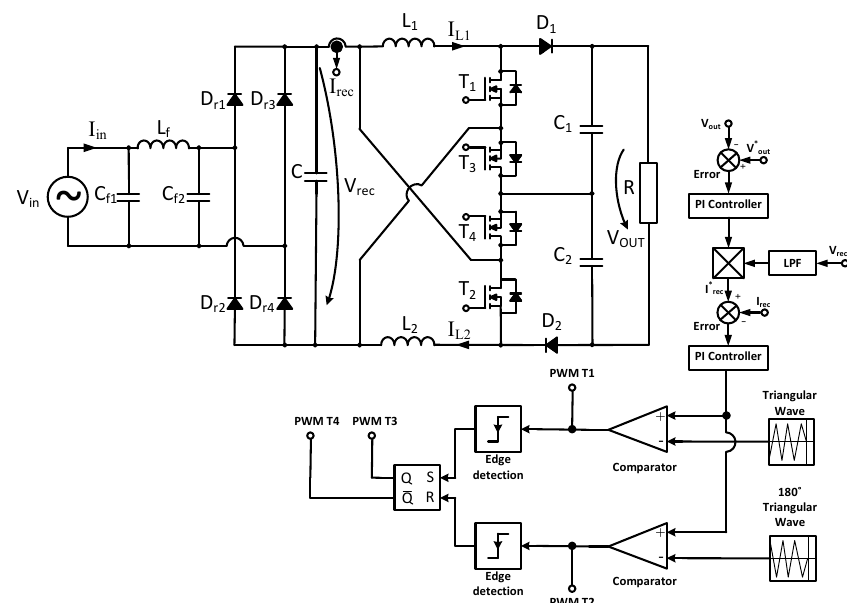
Figure 4. The generic output voltage control loop and PWM generator. V in —AC input voltage; V rec — rectified voltage; V out —DC output voltage; V* out —reference DC output voltage; I rec —rectified cur- rent; I* rec —reference rectified current; I in —input current; PWM T1, PWM T2, PWM T3 and PWM T4 – Gate-Source voltage for T 1 —T 4 transistors.